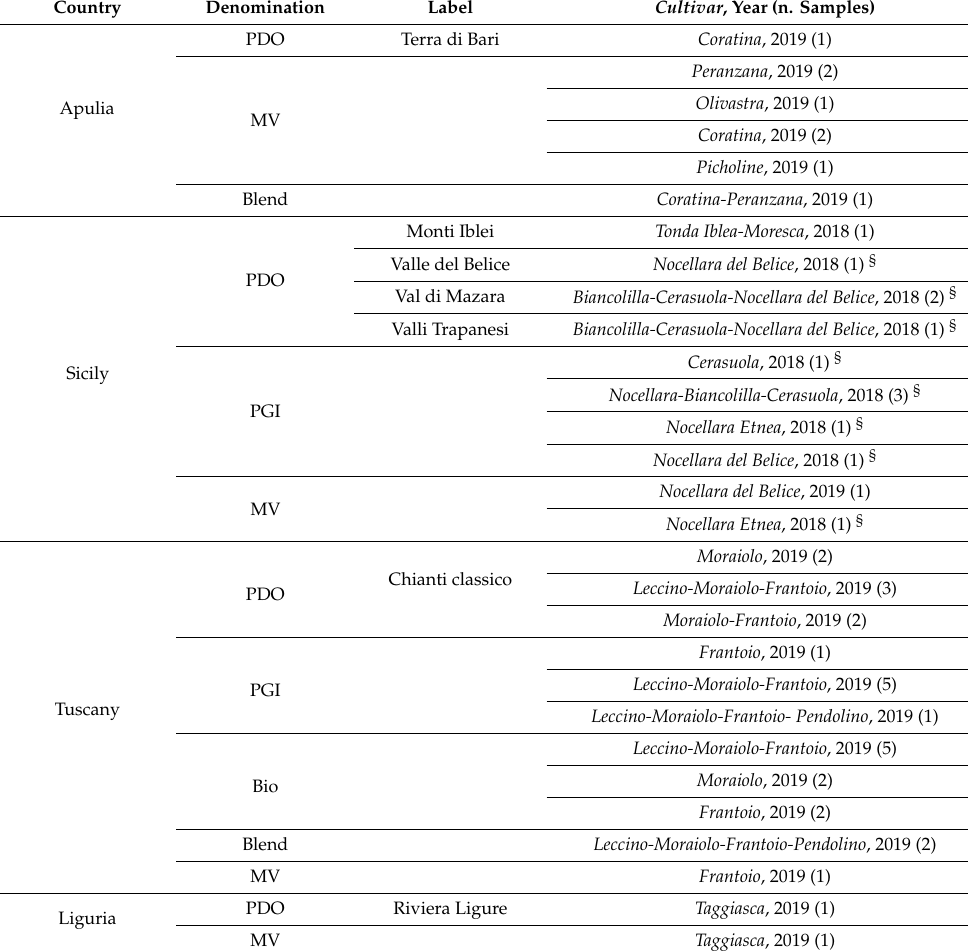
Table 1. High quality and commercial § extra-virgin olive oils